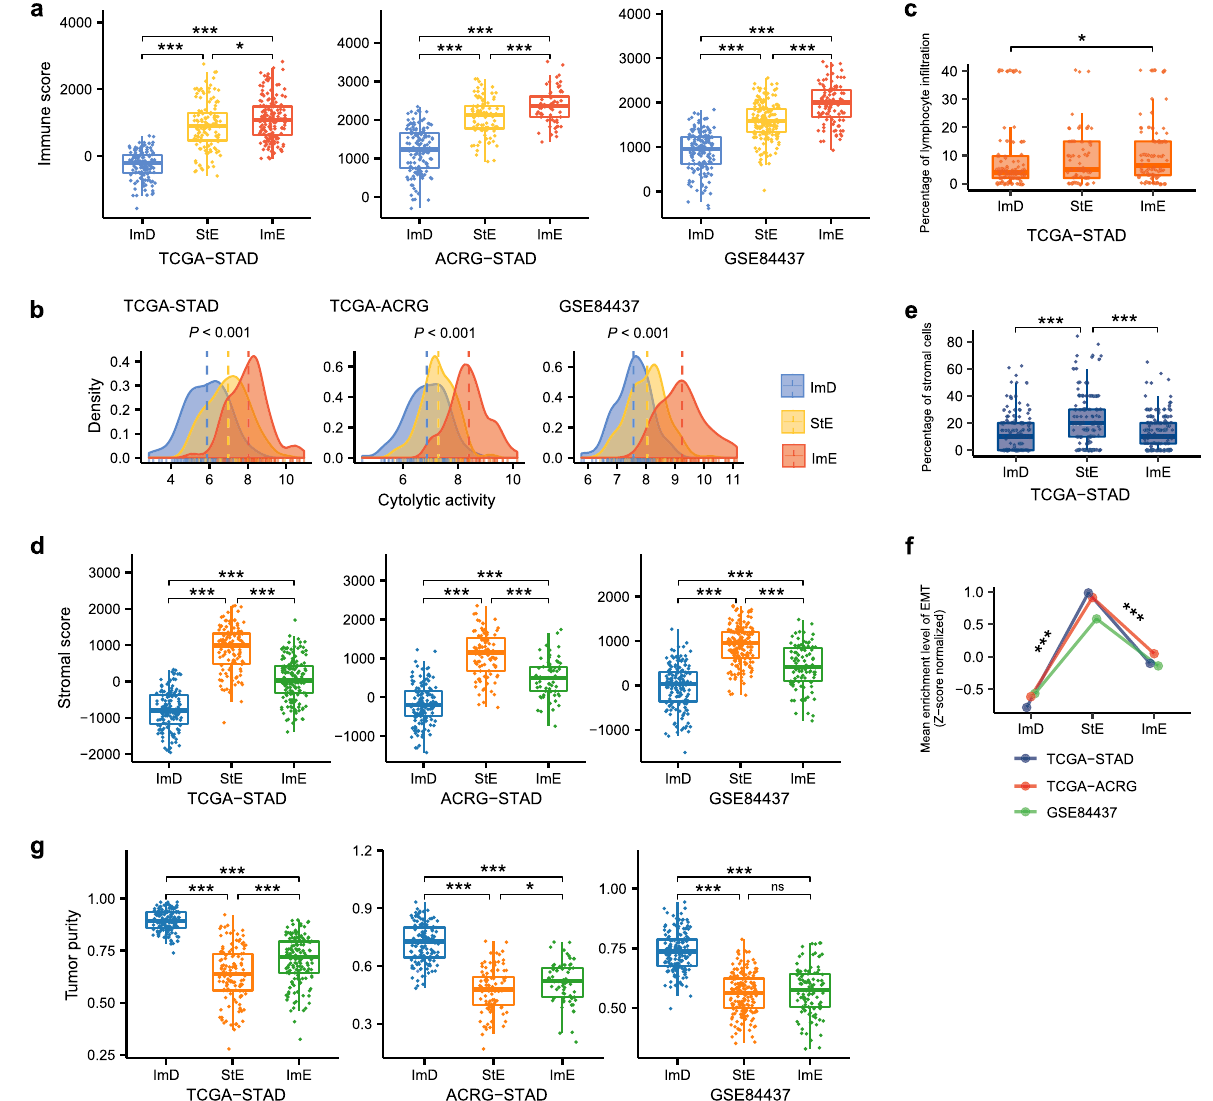
Fig. 2 Comparisons of immune and stromal signatures and tumor purity between the three GC subtypes. The immune scores ( a ), cytolytic activity ( b ), and percentages of lymphocyte in fi ltration ( c ) are the highest in ImE and the lowest in ImD. The stomal scores ( d ), percentages of stromal cells ( e ), and activity of EMT ( f ) are the highest in StE and the lowest in ImD. g ImD has the highest tumor purity, and StE has the lowest tumor purity. The immune and stomal scores and tumor purity were evaluated by ESTIMATE 31 . The cytolytic activity is the average expression level of two marker genes ( GZMA and PRF1 ) 32 . The activity of EMT is the ssGSEA score 26 of its marker genes. The one-tailed Mann – Whitney U test P values are indicated. * P < 0.05, ** P < 0.01, *** P <